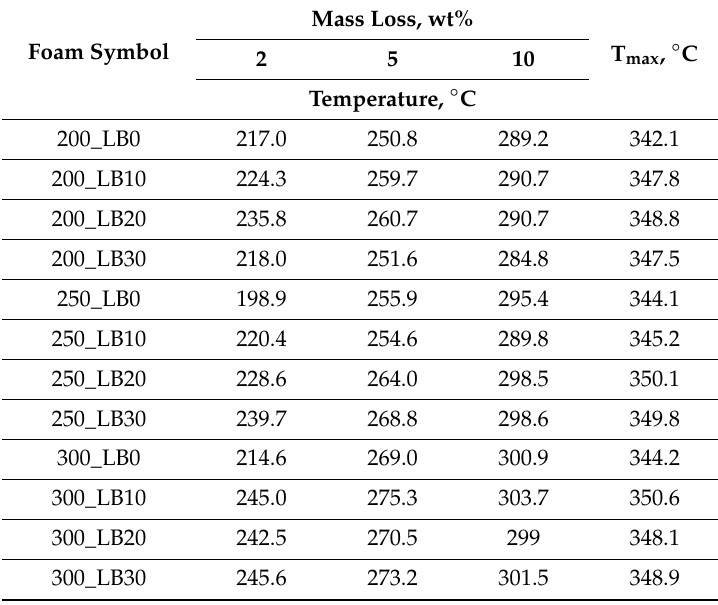
Table 8. Results of thermogravimetric analysis of PUR-PIR